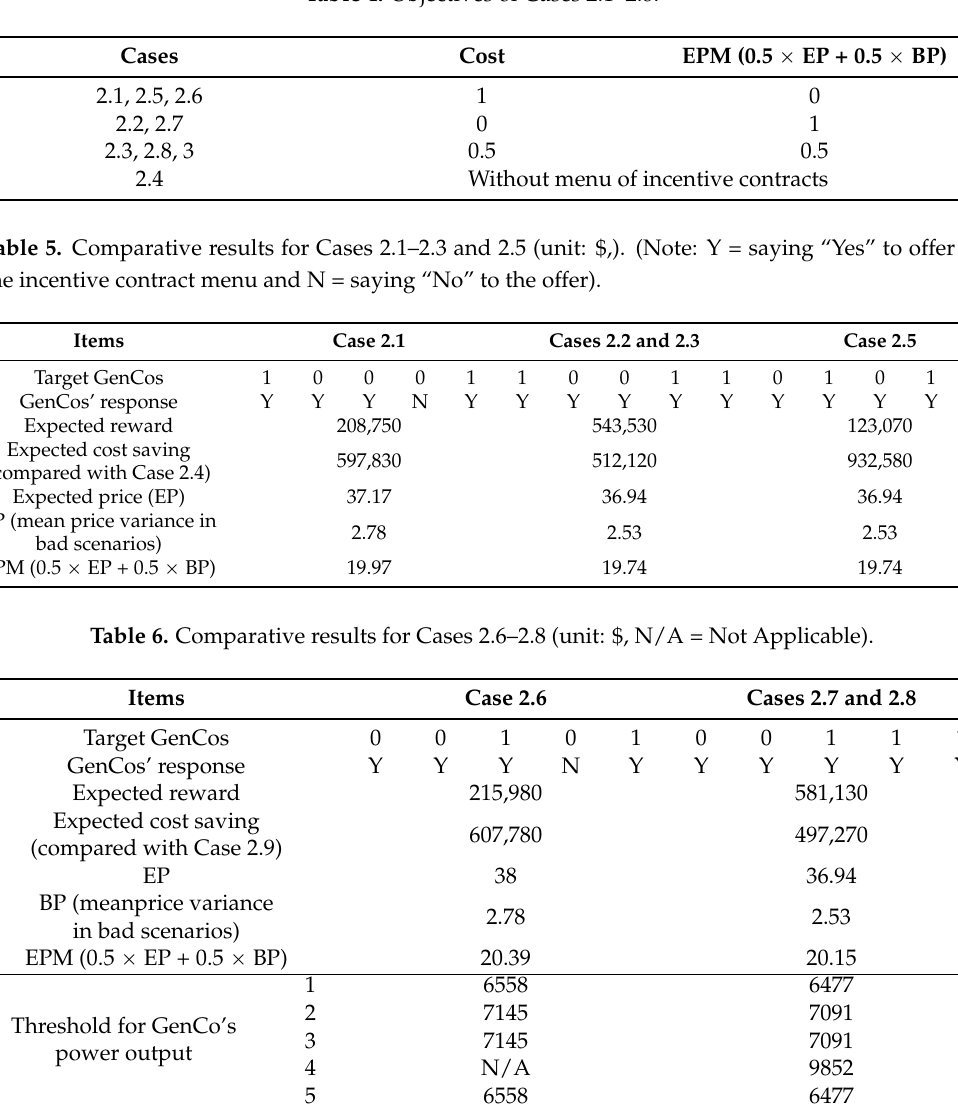
Table 4. Objectives of Cases 2.1–2.8.